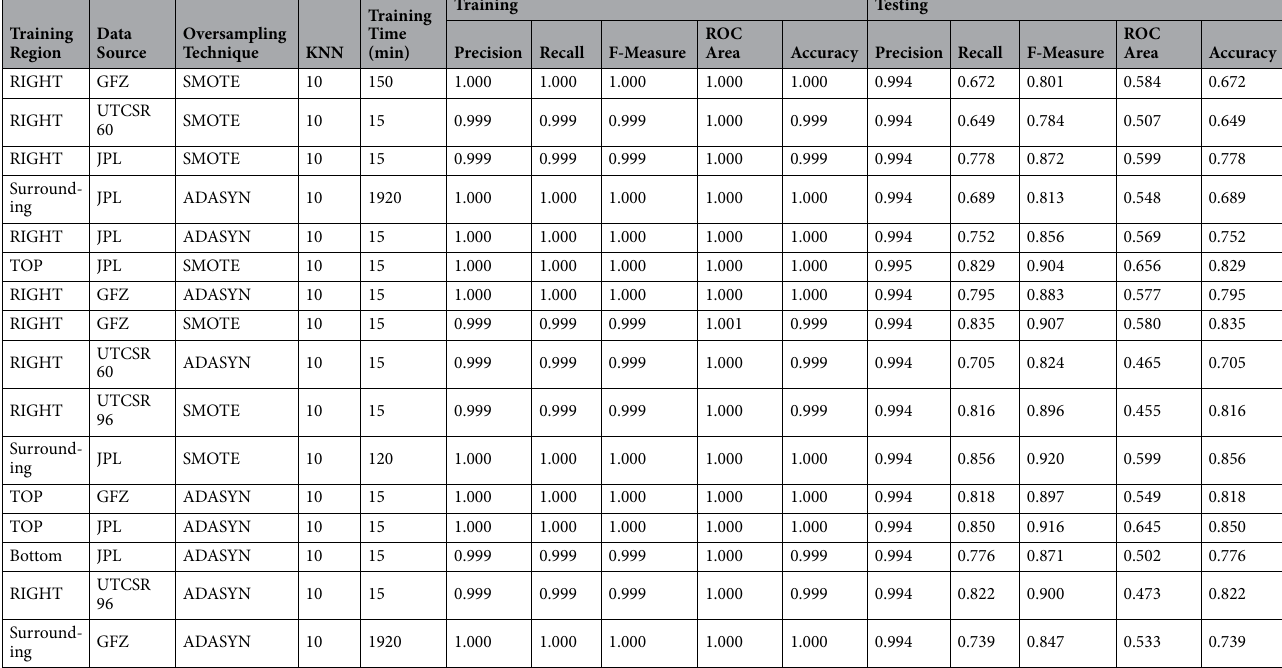
Table 3. Evaluation metrics for trained